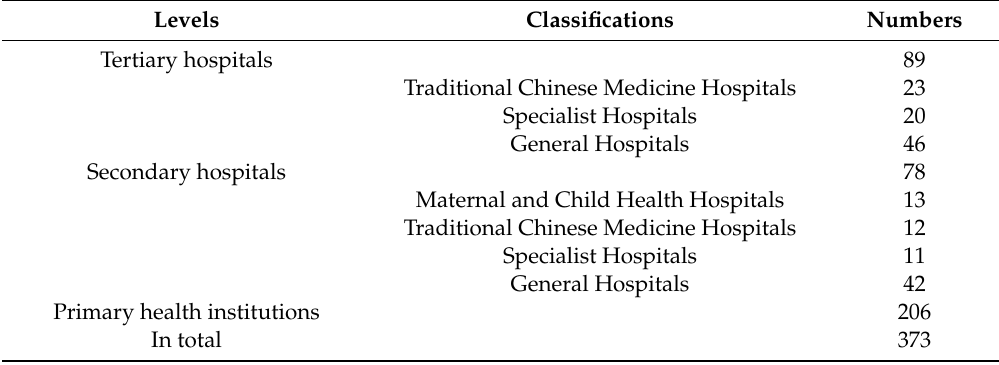
Table 2. The levels and classifications of monitored public medical